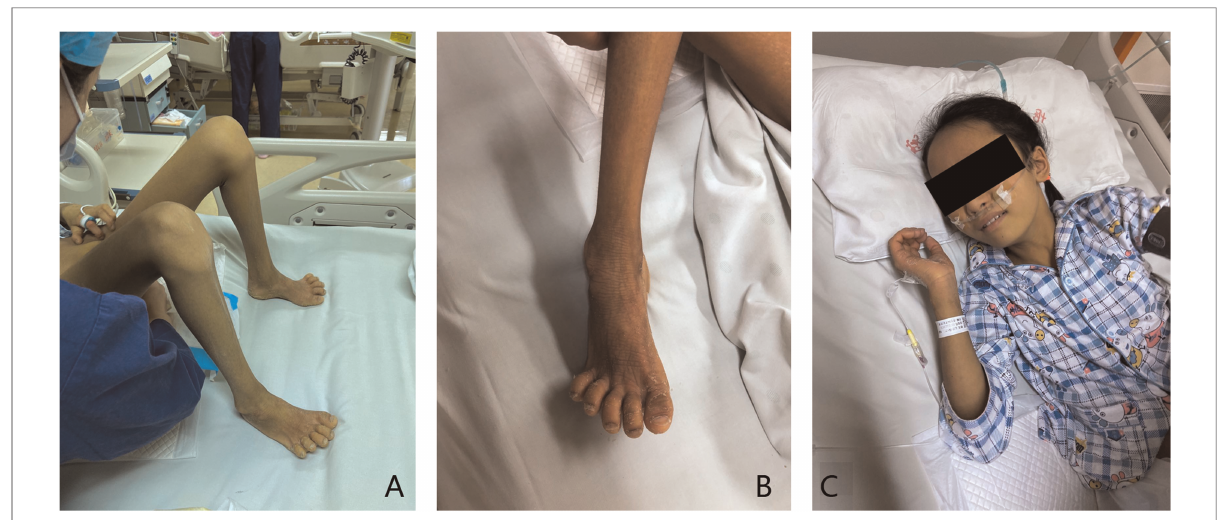
FIGURE 1 Clinical symptoms. ( A ) Joint contracture can be seen in the fi nger and toe joints of the patient. ( B ) The patient has dry skin and hand and foot desquamation, which is the manifestation of ichthyosis. ( C ) The patient has a yellow skin stain all over the body, accompanied by icteric